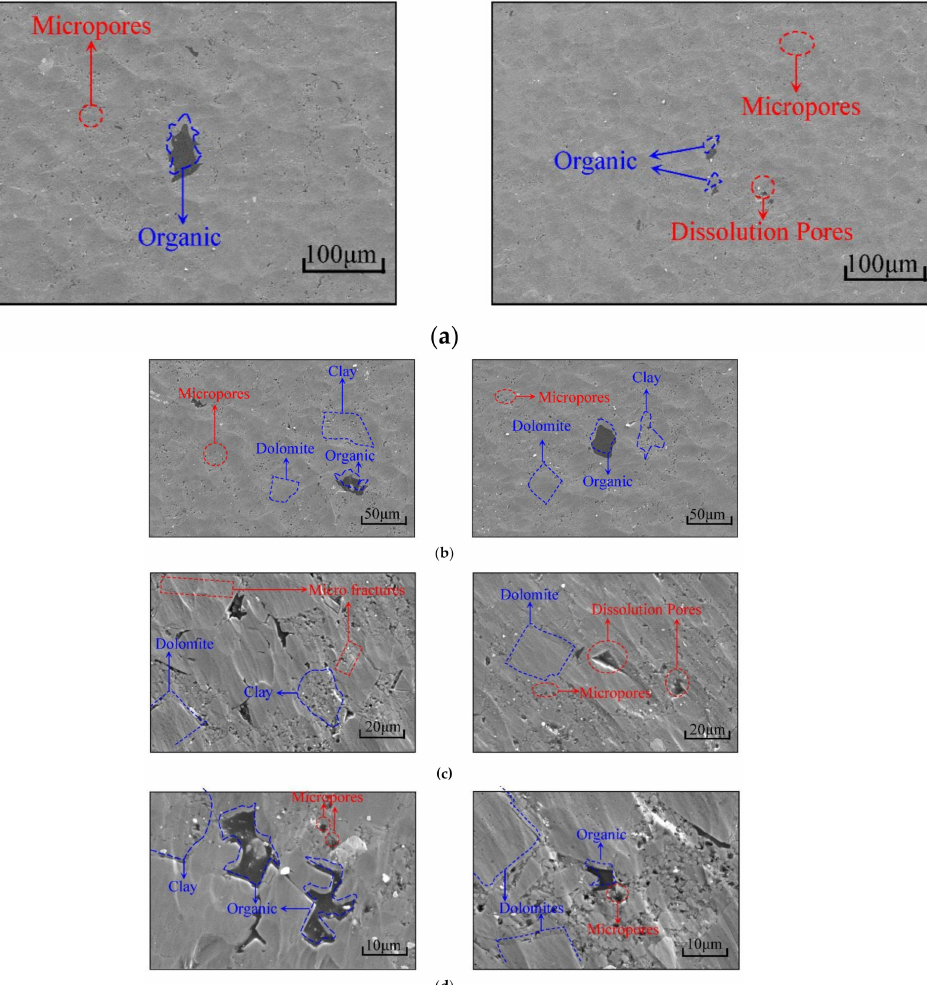
Figure 5. SEM images in different fields of shale: ( a ) 1200 × magnification, ( b ) 2000 × magnification, ( c ) 5000 × magnification, ( d ) 8000 ×